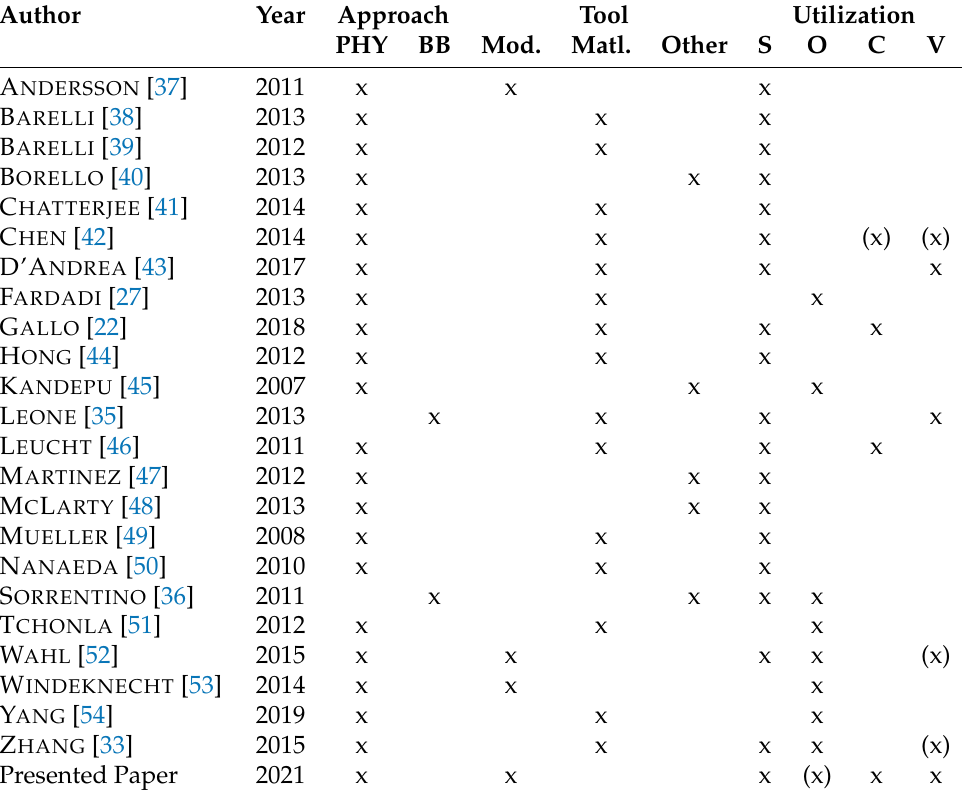
Table 1. Published dynamic SOFC system models regarding the modeling approach, tools